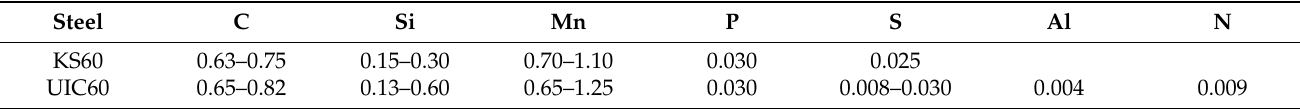
Table 1. Chemical composition of rail steel (wt.%).